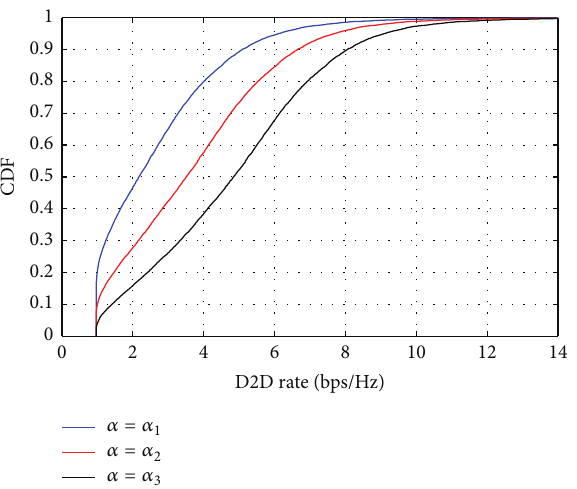
Figure 4: D2D rate distribution under different 𝛼 .